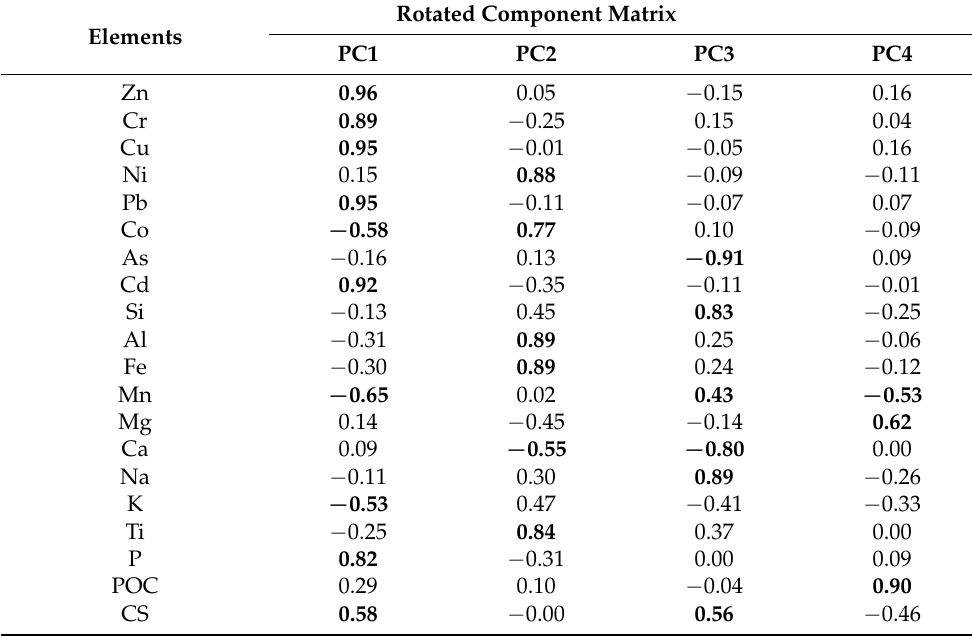
Table 3. PCA components for total concentrations of major and trace metals in the Sebou sediments and the corresponding percentages of the variance and correlation coefficients (significance level p < 0.05 in bold). CS: Coarse Silts; FS: Fine